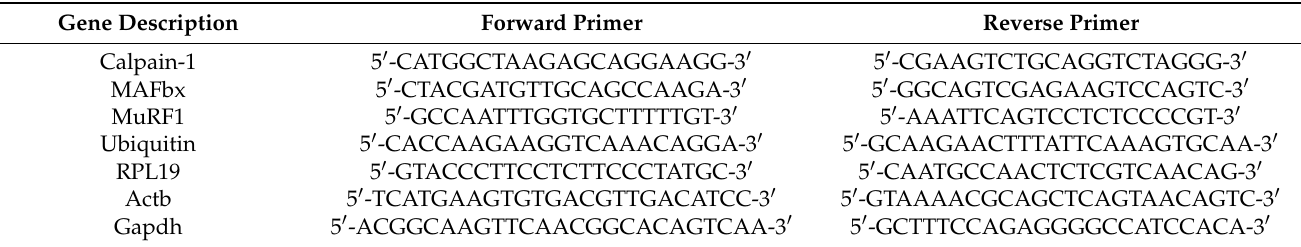
Table 1. Primers used for RT-PCR